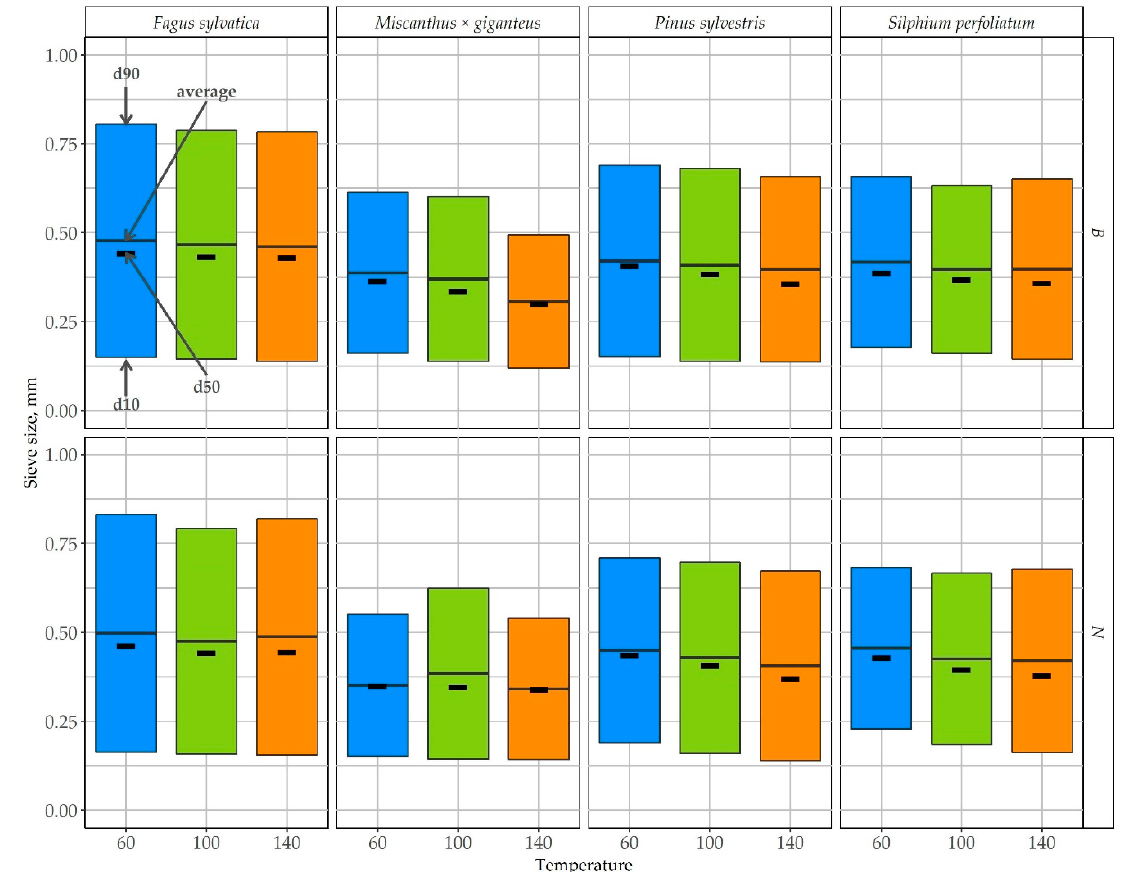
Figure 8. Grindability plot where B is the hammer milling system and N is the knife milling system.